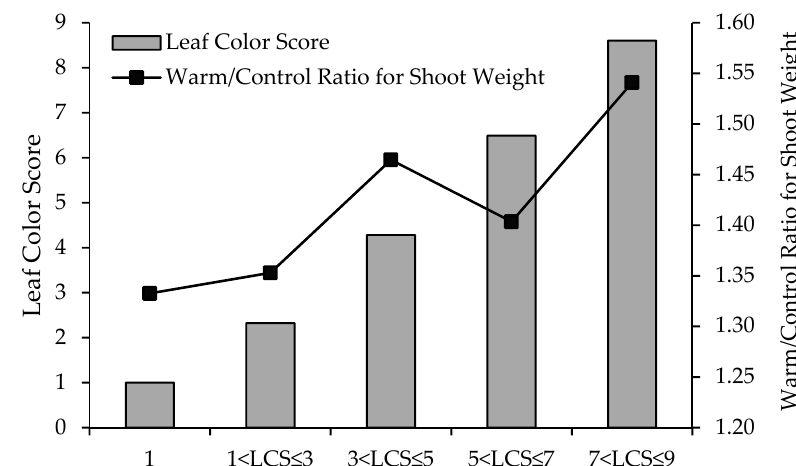
Figure 7. The combination of the average warm/control ratio for shoot weight and leaf color score of rice varieties in the warming treatment experiment.